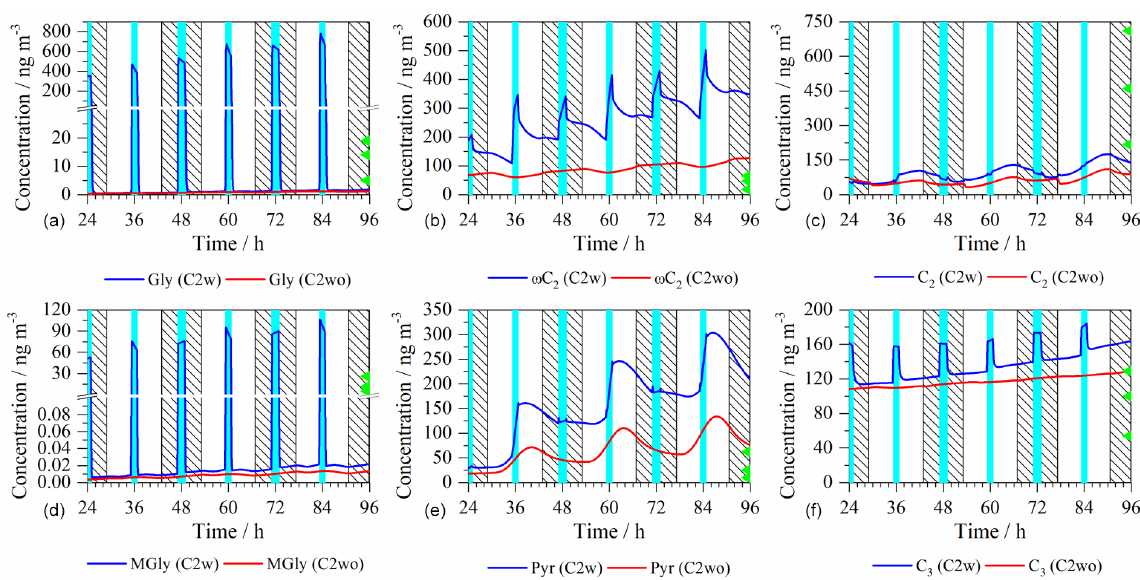
Figure 5. Time series of the modeled aerosol mass concentrations of selected DCRCs ( a, b, c Gly, ω C 2 , and C 2 ; d, e, f MGly, Pyr, and C 3 ) in the C2w and C2wo cases. Light blue column: cloud; shadow: night; green triangle: the maximum (above), average (middle), and minimum (below) value of measured concentrations at Mt.